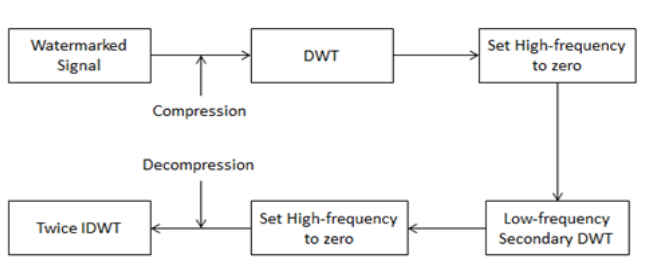
Figure 5. Data compression